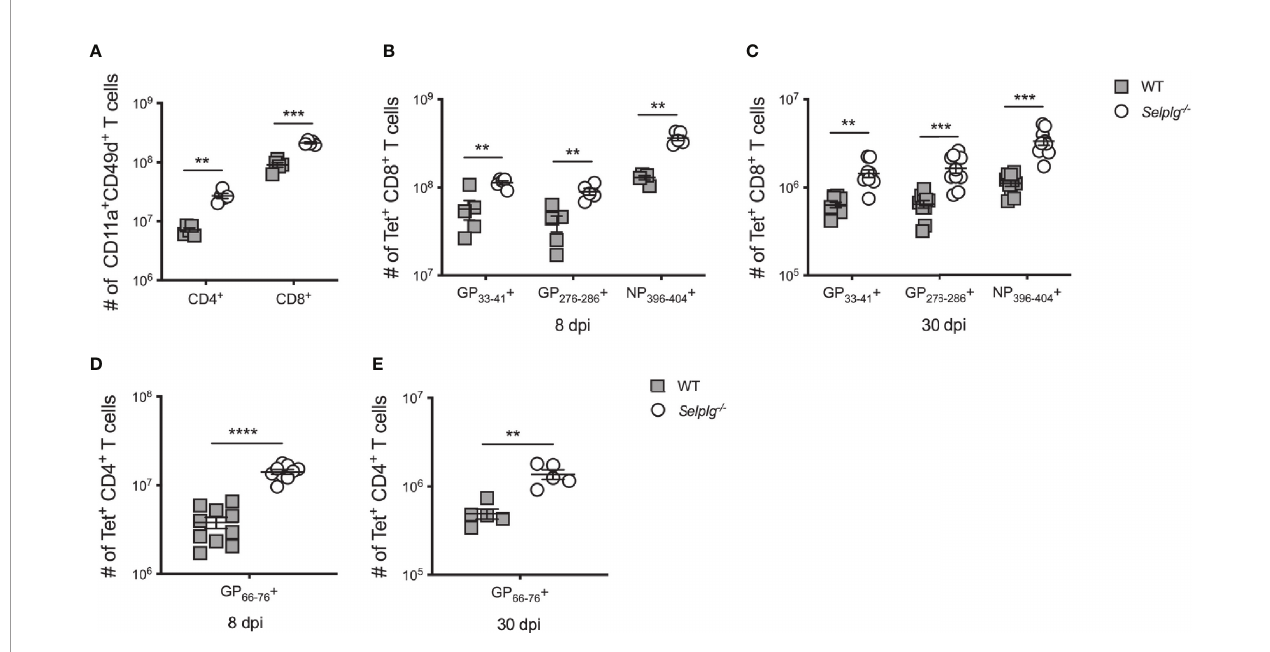
FIGURE 1 | Increased accumulation of Selplg-/- T cells during LCMV infection. WT and Selplg -/- mice were infected with LCMV Armstrong by i.p. injection. (A) The numbers of antigen responding CD11a + CD49d + T cells in spleen at 8dpi. Tetramer + CD8 + T cells in the spleens were enumerated at 8dpi (B) and 30dpi (C) . Tetramer + CD4 + T cells were enumerated in the spleens at 8dpi (D) and 30dpi (E) . Data are representative of four independent experiments (n = 5 or more mice/ group). Graphs show the mean ± SEM. ** p < 0.005, *** p < 0.001, **** p < 0.0001 by two-tailed unpaired t-